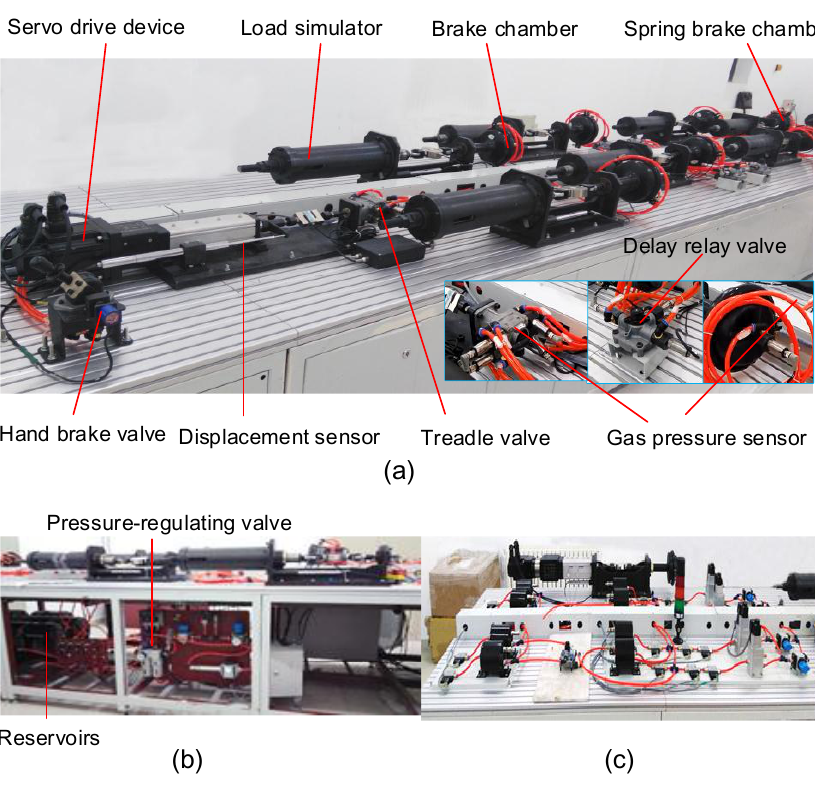
Figure 4. Operation desk of the test bench ( a ) The main operation zone ( b ) Gas supply devices ( c ) A specific test bench for calibrating the pneumatic subassemblies.